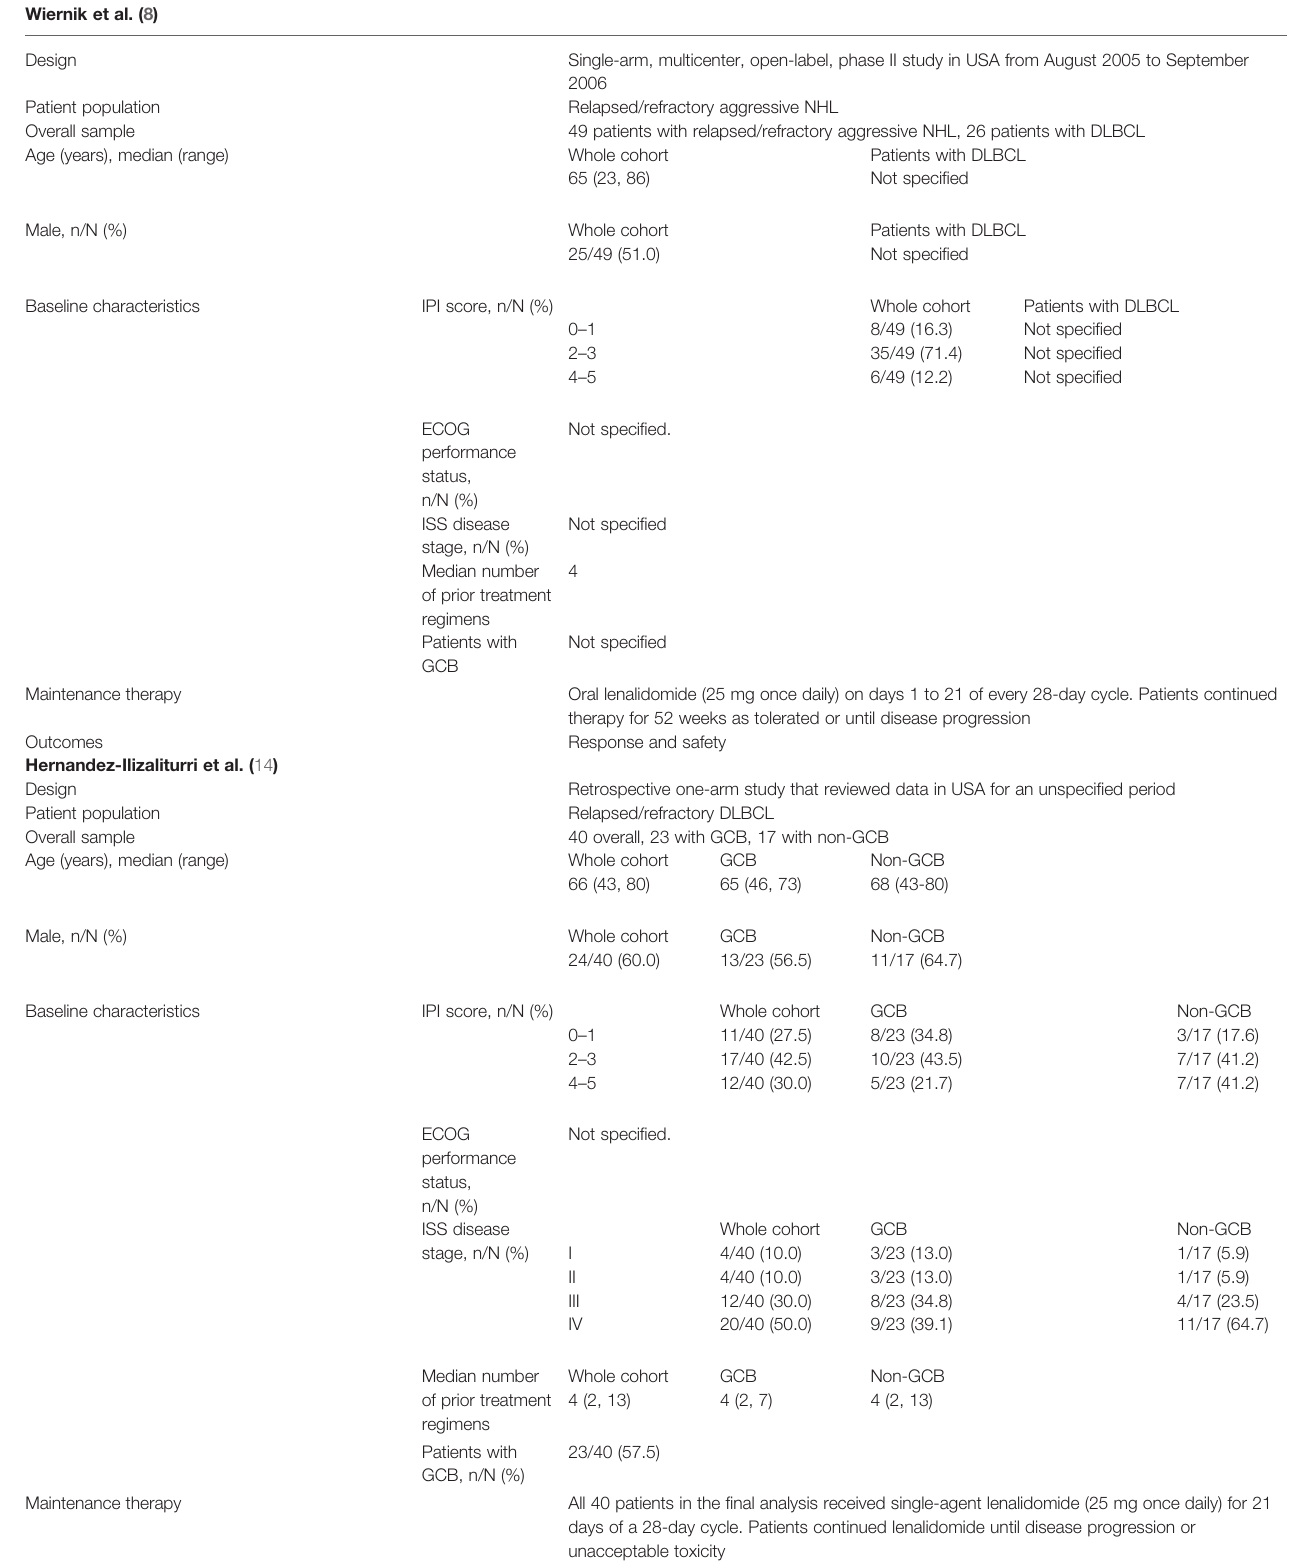
TABLE 1 | Characteristics of included